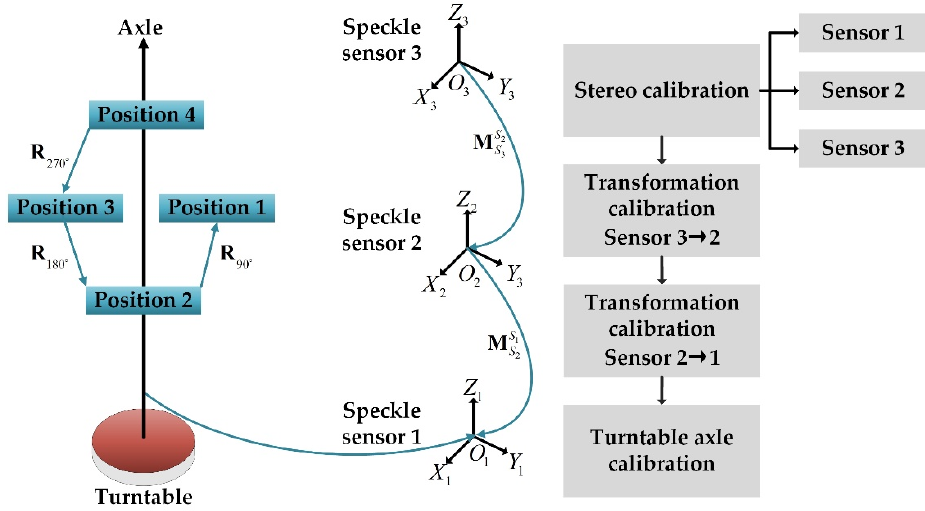
Figure 1. Scheme design for human body 3D scanning.